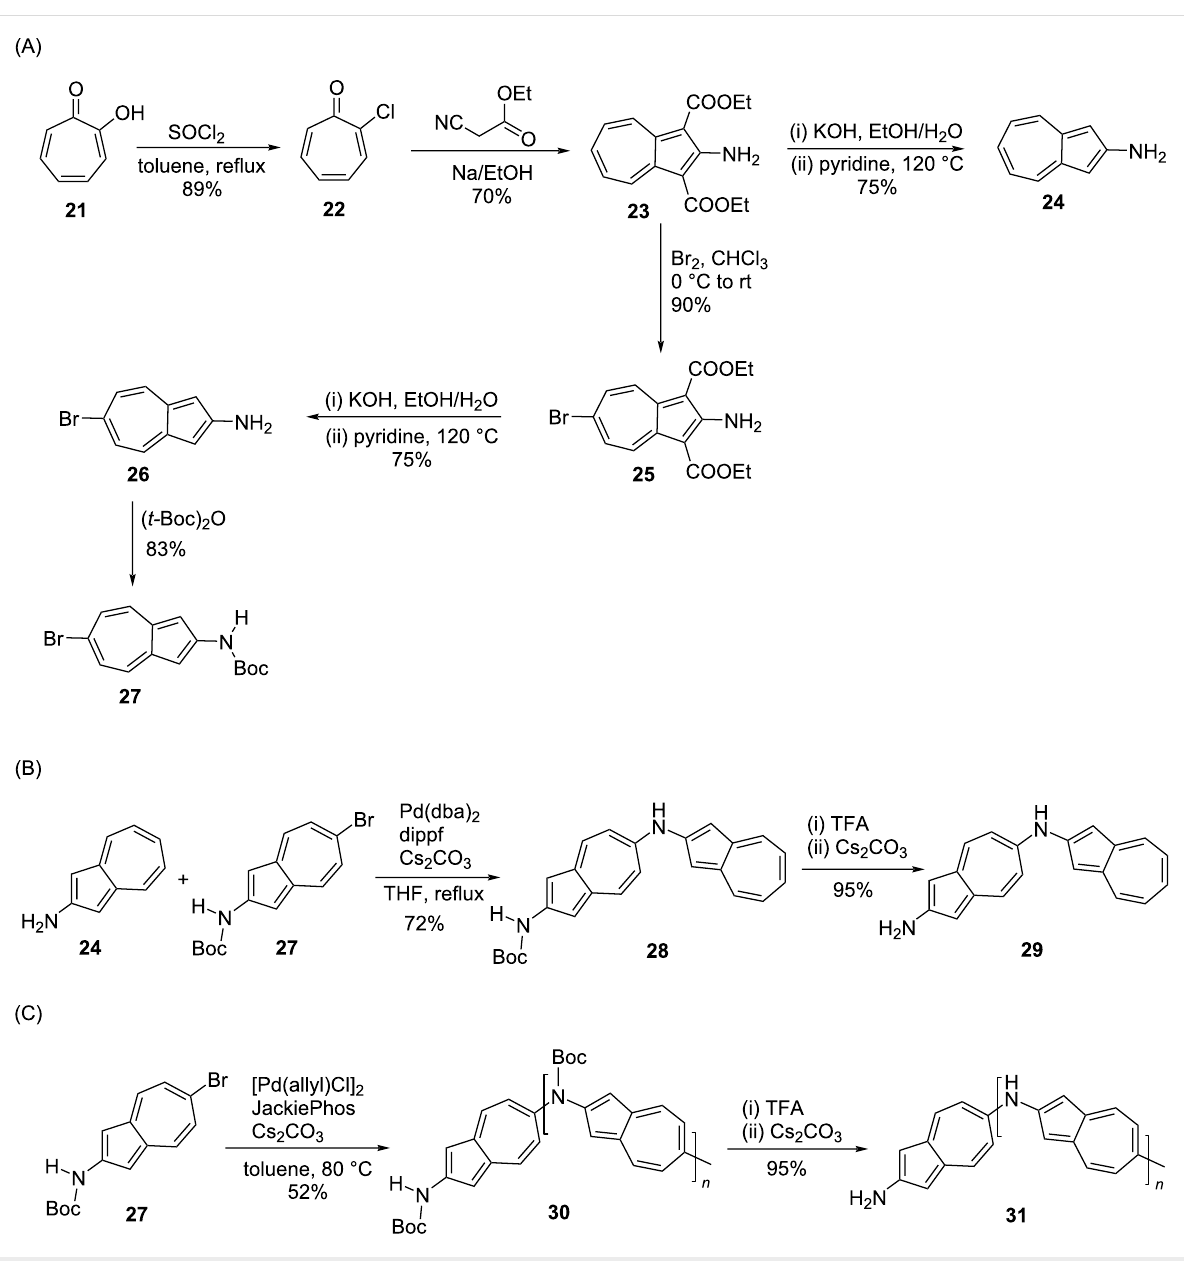
Scheme 7: Synthesis of (A) tert -butyl N -(6-bromoazulen-2-yl)carbamate ( 27 ), (B) dimeric aminoazulene 29 , and (C) poly[2,6-aminoazulene] 31